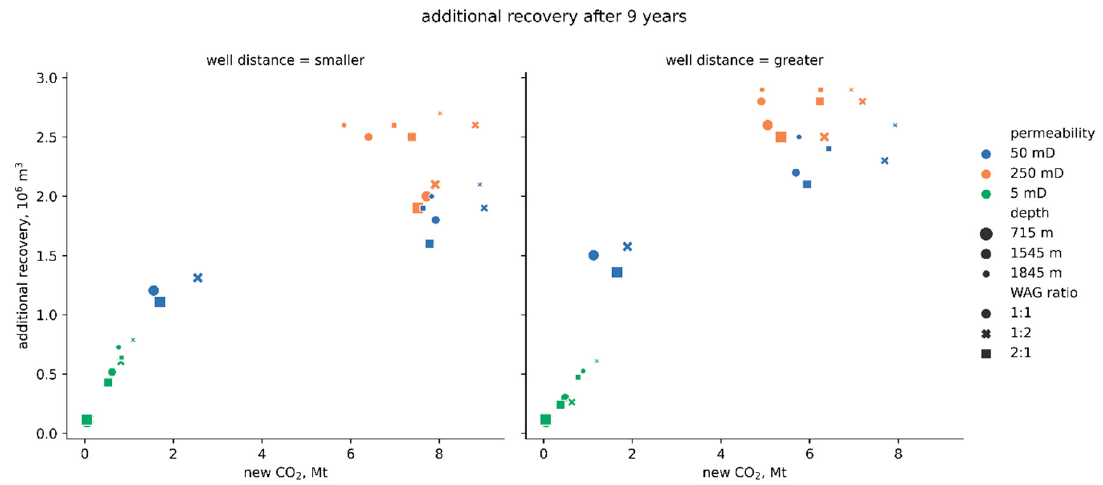
Figure A7. Additional recovery versus new CO 2 after 9 years of EOR.